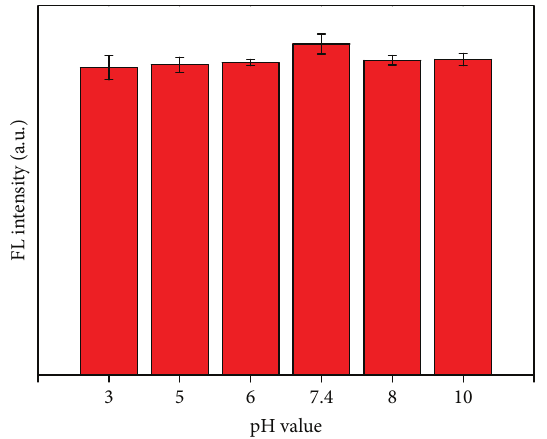
Figure 2: FL intensity of CDs in aqueous solutions with different pH values. All values were obtained based on three independent measurements.